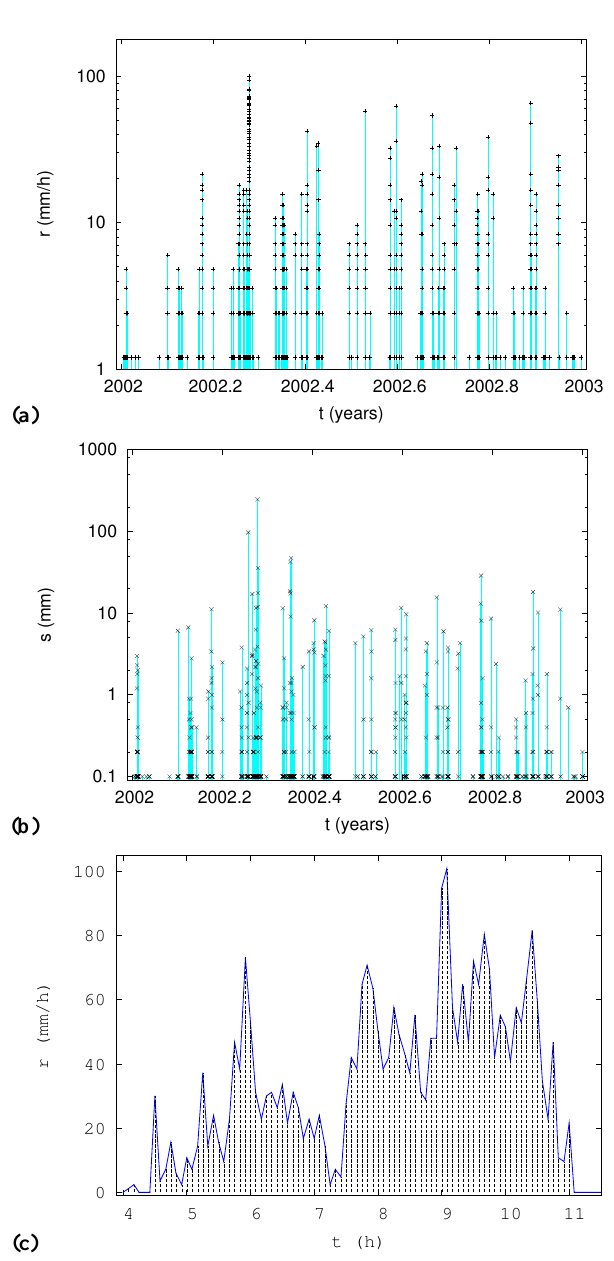
Fig. 1. (a) Subset of the rain rate time series for site 17 (Muga) for year 2002. (b) More reduced subset of the rain rate time series for the same site, corresponding to the largest rain event on the record, with s = 248 . 7mm, on 11 April 2002. Time refers to hours since midnight. A very small rain event is also present at the beginning, with s = 0 . 3mm and separated to the main event by a dry spell of duration q = 15min. (c) Corresponding event-size time series for the same site, for year